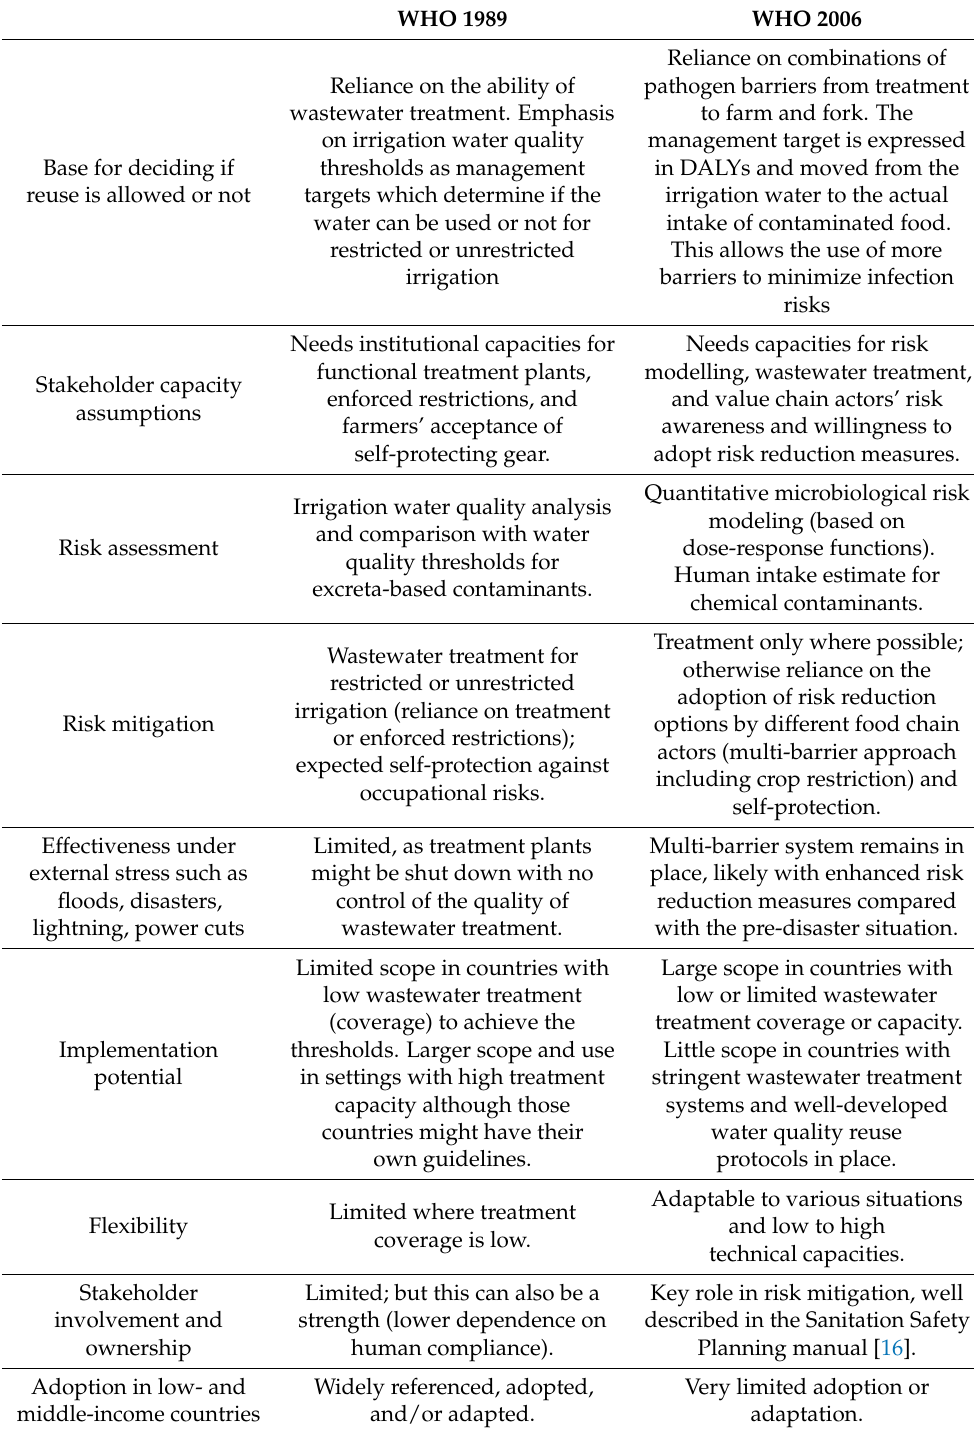
Table 1. Selected differences between the WHO’s 1989 and 2006 wastewater use